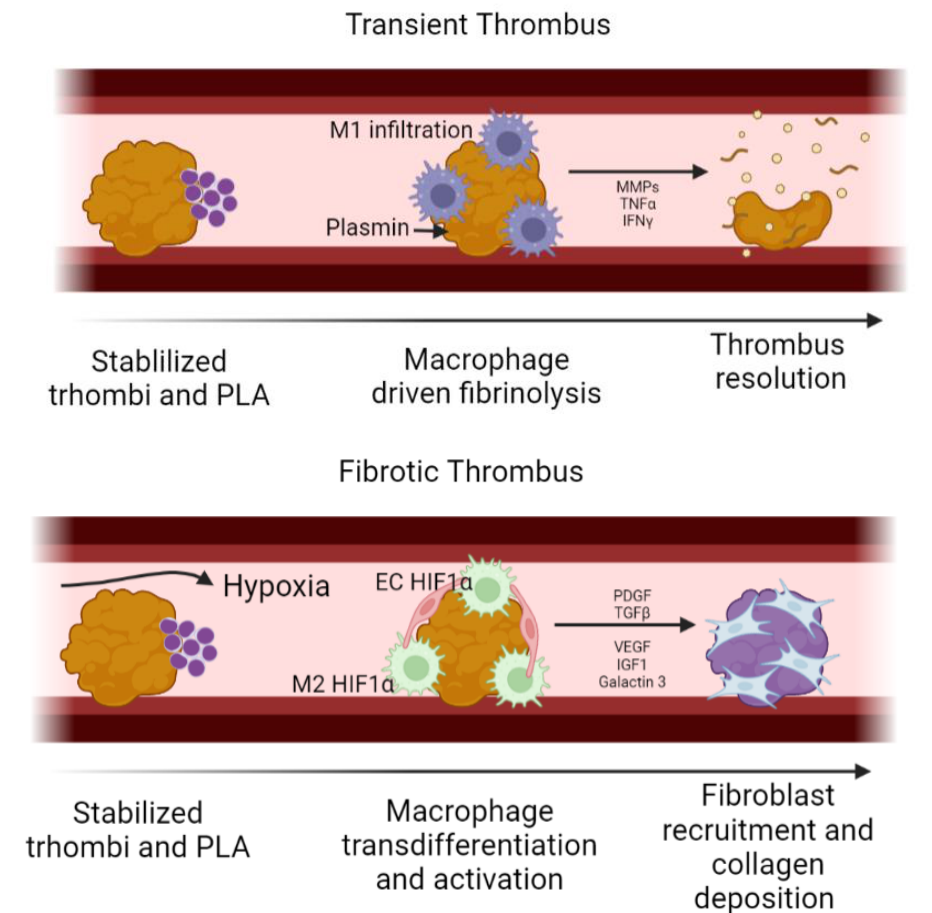
Figure 3. Proposed cellular events related to fibrotic thrombus generation on a TEVG. Upper image: transient thrombus is degraded by the action of M1 macrophages. However, a thrombogenic material with extended thrombus formation can promote hypoxia in the downstream cells infiltrating the vascular wall. Lower image: under hypoxia, M1 macrophages expressing the HIF1α increase the production and release of VEGF, causing angiogenesis. Hypoxia also induces M1 transdifferentation to M2 phenotype, which will release growth factors for extracellular matrix (ECM) derived fibroblast remodeling into the thrombus. (Created with BioRender.com, accessed on 3 February 2022).